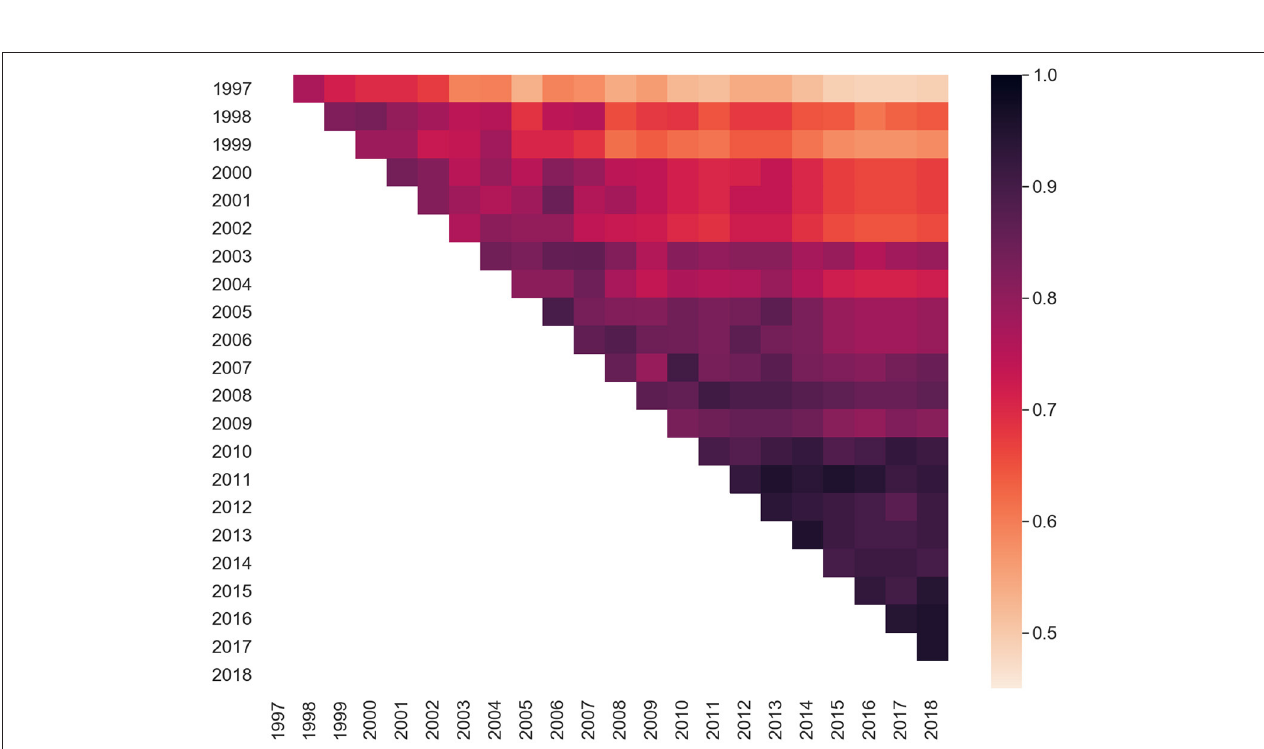
FIGURE 7 | Jaccard similarity heatmap of keywords over pairs of years as an indicator of terminology consolidation in time.